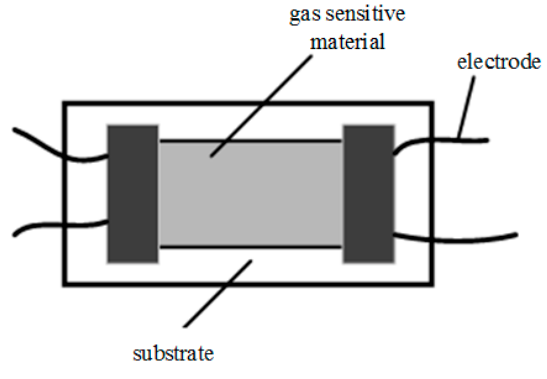
Figure 1. Resistive gas sensor structure.